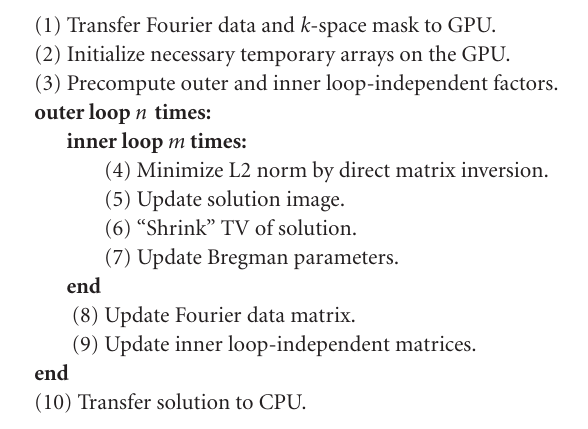
Algorithm 1: GPU-based Split Bregman Compressive Sensing Reconstruction.